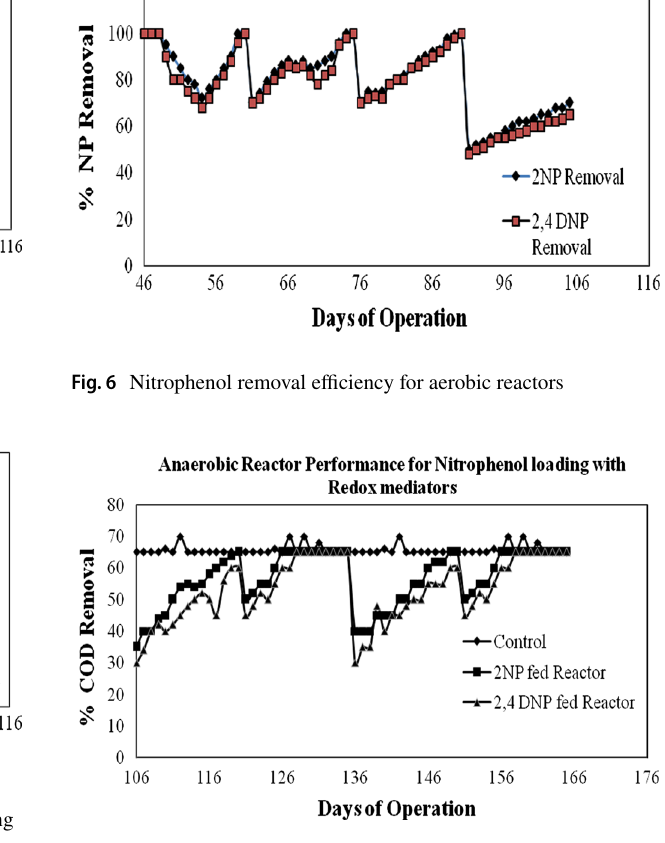
Fig. 7 COD removal for anaerobic reactors for 40 mg/l with redox